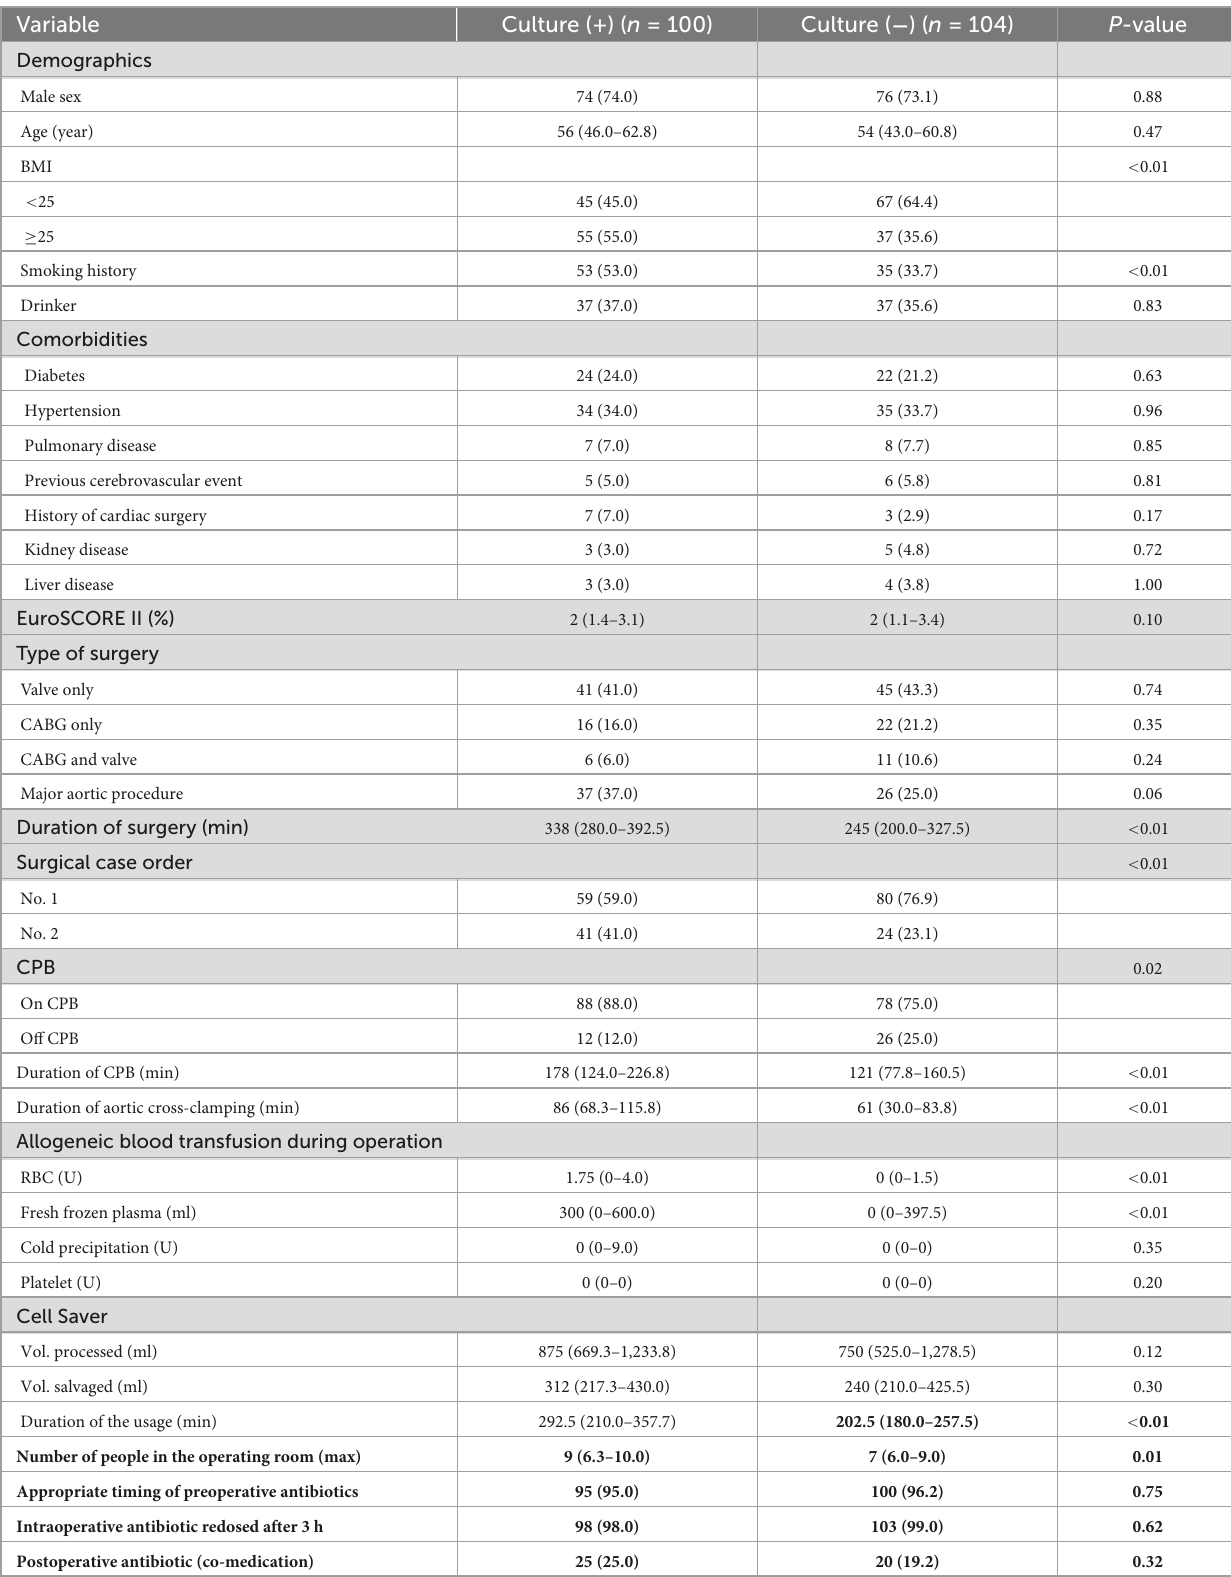
TABLE 1 Patient baseline and perioperative